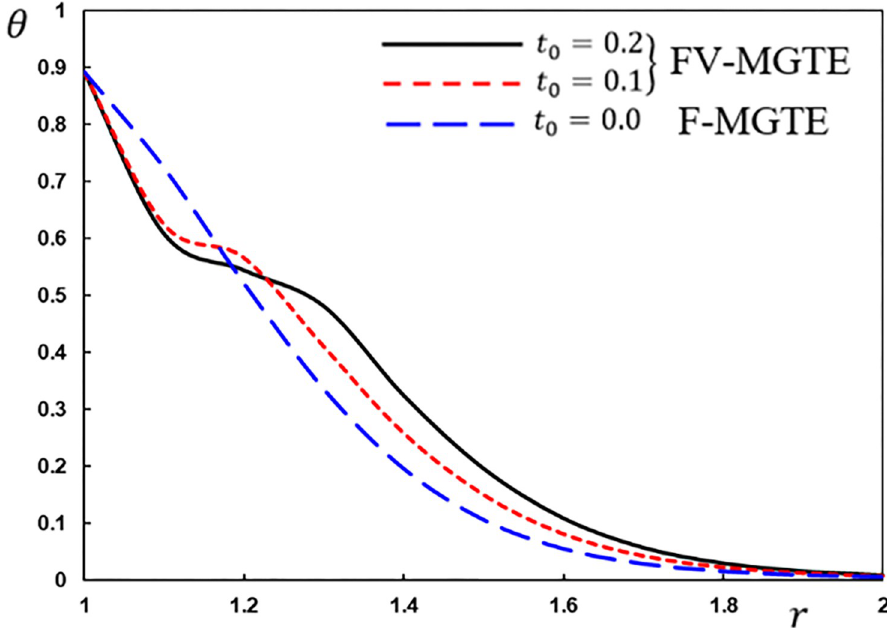
Fig 13. The temperature variation θ for different viscosity parameter η